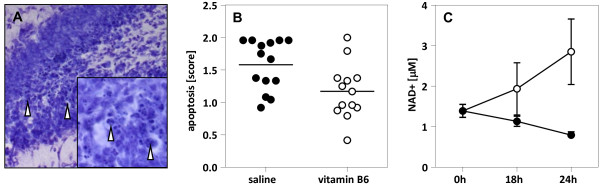
Apoptosis in the rat hippocampal dentate gyrus after infection with S. pneumoniae. A: Histomorphological analysis show neurons forming apoptotic bodies (arrowhead), a morphological feature characterisitc for programmed cell death and evenly distributed over the lower and upper blade of the hippocampal dentate gyrus (Cresyl violet, original magnification 20× and 40× (insert)). B: The mean score of apoptotic cells (represented by the horizontal lines) in the vitamin B6-treated group is significantly smaller than the score of placebo-treated rats (unpaired t test, p > 0.02). C: Hippocampal NAD+ levels were measured at 3 different time points after infection. The amount of NAD+ in placebo-treated rats (solid circles; vertical bars show standard deviation) gradually decreases over time as an index of depletion of cellular energy stores in the hippocampus of infected rats. In contrast, the NAD+ level of rats treated with vitamin B6 (bare circles) rises from the time of infection to 24 h post-infection. Statistical analysis was performed using GraphPad Prism 4 (GraphPad Software, San Diego California, USA).